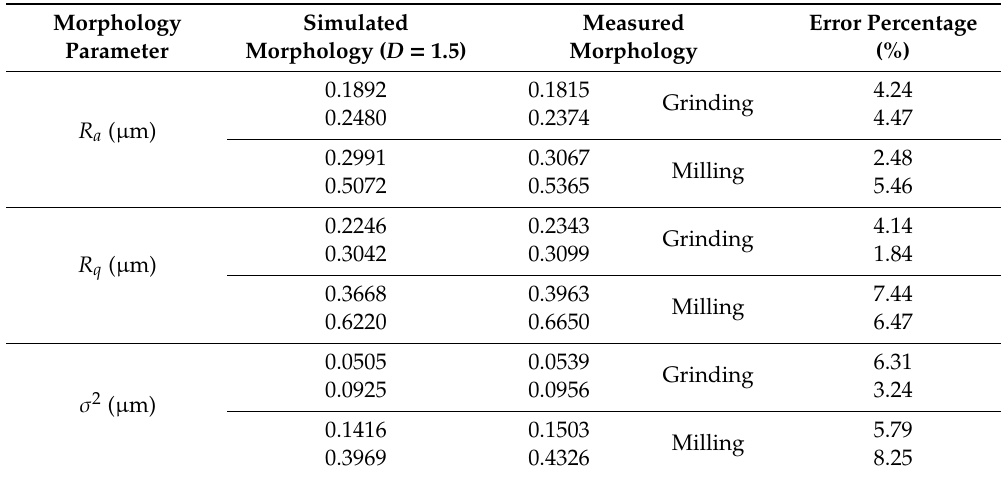
Table 3. Comparison parameters of simulated and practical